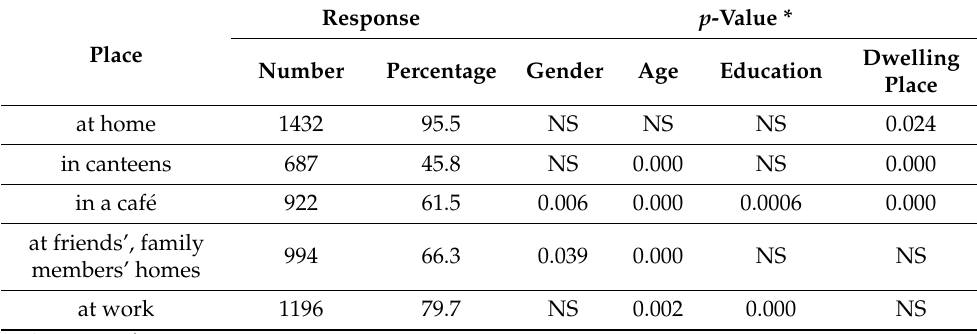
Table 3. Places of respondents drink